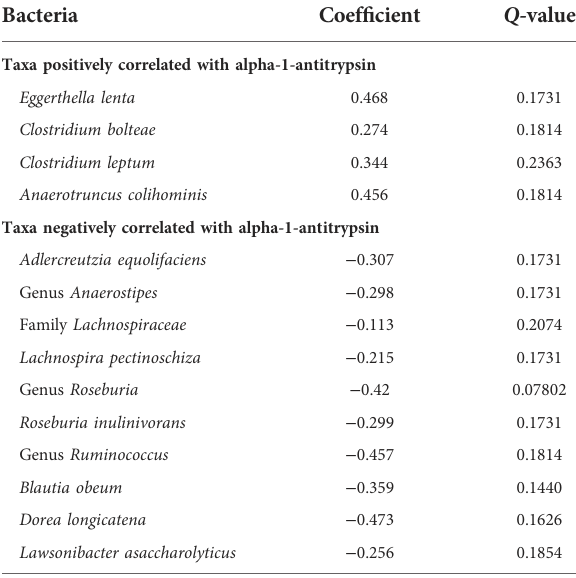
TABLE 2 Microbial taxa associated with fecal